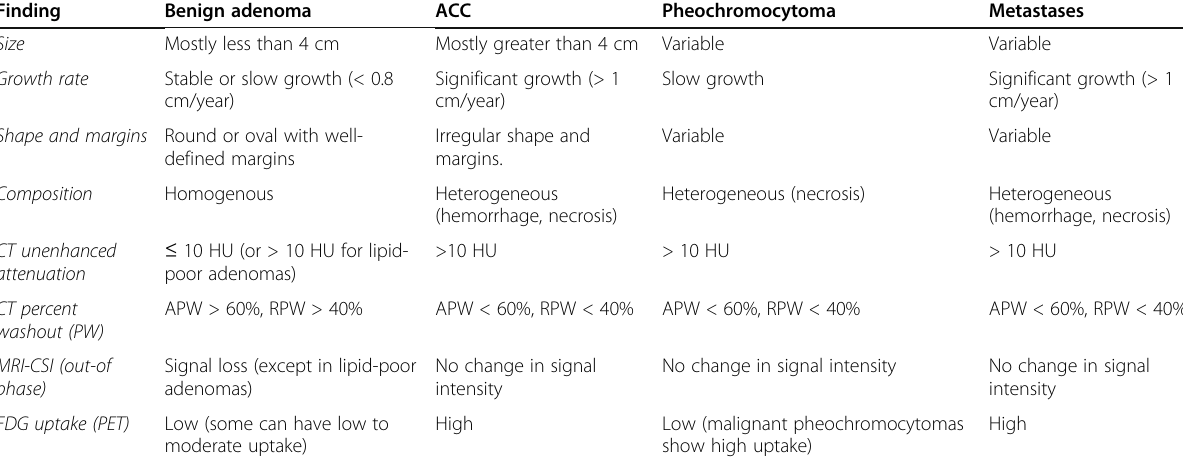
Table 1 Imaging findings differentiating common adrenal pathologies in AIs